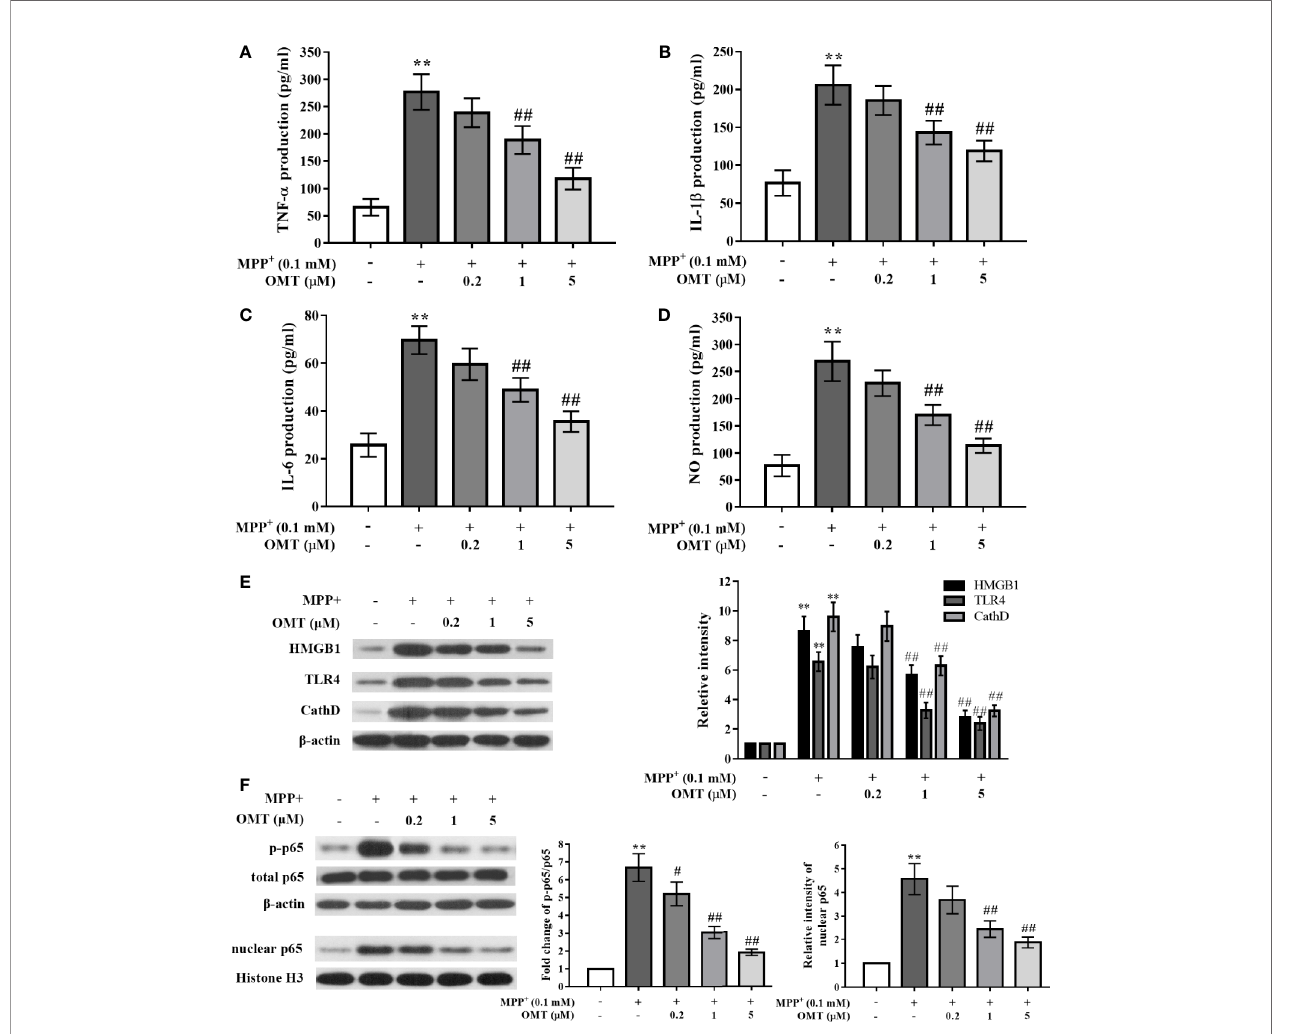
FIGURE 4 | OMT suppressed proin fl ammatory cytokines production and inhibited HMGB1/TLR4/NF- k B activation in MPP + -induced mice primary microglia. Mice primary microglia was pretreated with 0.1 mM MPP + and incubated for 6 h, followed by treatment with 0.2, 1, or 5 m M OMT for 24 h. (A – D) Levels of pro- in fl ammatory cytokines, such as TNF- a (A) , IL-1 b (B) , IL-6 (C) , and NO (D) in MPP + -induced primary microglia were tested by ELISA analysis. (E , F) The expression levels of CathD, HMGB1, TLR4 (E) , p-p65, and total p65 whole cell expression as well as p65 nuclear expression (F) in MPP + -induced primary microglia were tested by Western blot analysis. The data are presented as mean ± SEM. **p < 0.01 vs. Control cells; ## p < 0.01 vs. MPP + -treated cells. # p < 0.05 vs. MPP+-treated cells. ANOVA with Bonferroni ’ s post-hoc